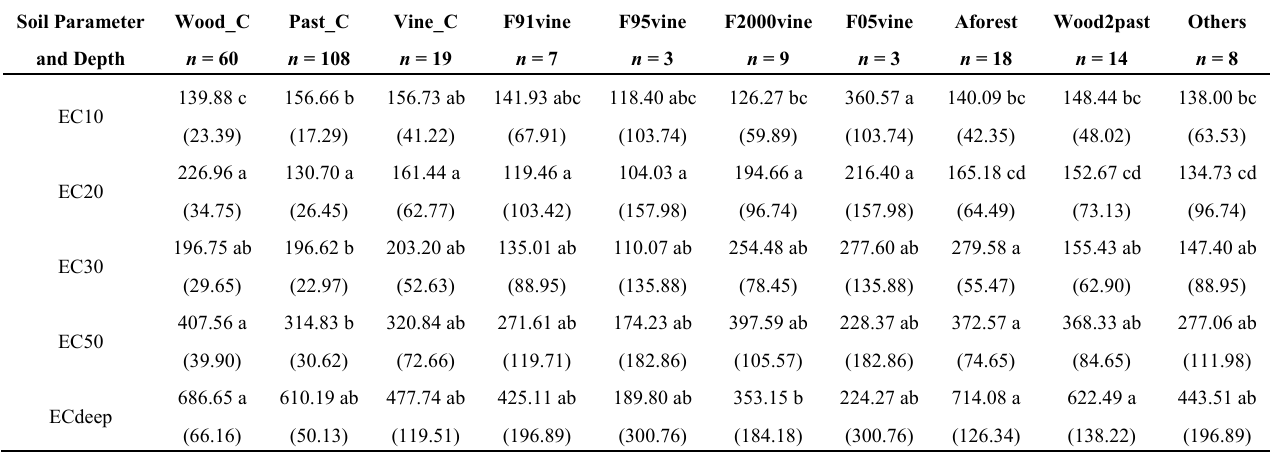
Table 3. Mean Electrical Conductivity (EC) (dS·m − 1 ) of soils under different land use and land cover (LULC) categories; values in brackets are the standard